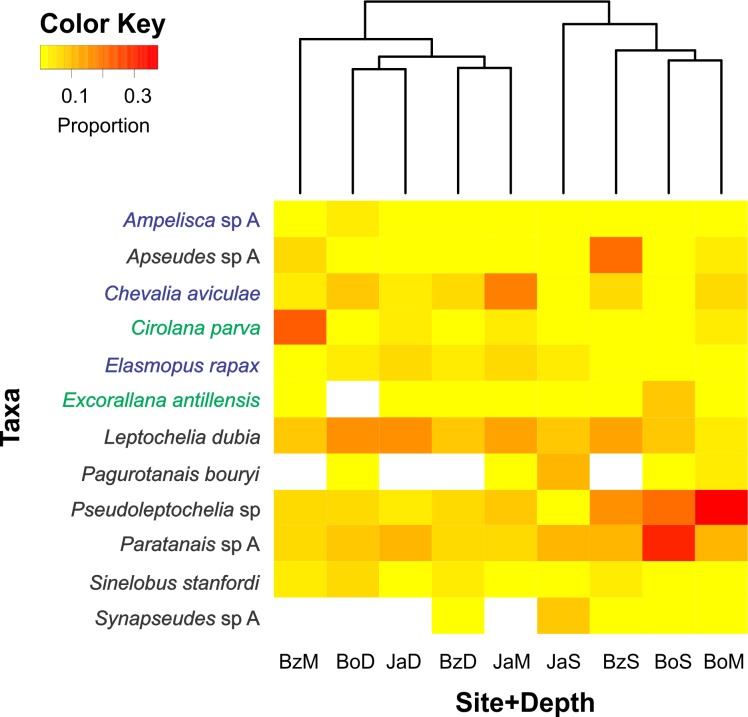
Relative abundance heatmap of cryptic peracarid taxa encountered within each site (Bz: Bonanza, Bo: Bocana, Ja: Jardines) and depth (S: shallow back-reef, M: fore-reef (6–8 m), D: fore-reef (10–12 m)) surveyed within the Puerto Morelos Reef National Park in 2013–2014.A Bray–Curtis dissimilarity dendogram on the top highlights the taxonomic dissimilarity among sites and depths. The 200 peracarid taxa were used for the clustering but only those that had a relative abundance higher than 5% are shown in the heatmap. Colour scale shows the proportion of each taxa within each site and depth. White squares indicate zero counts. Taxa in blue correspond to amphipods, in green to isopods and in black to tanaidaceans.